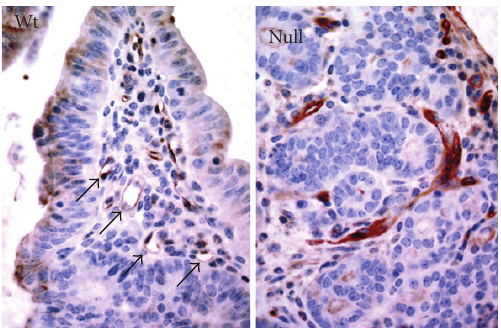
Figure 3: Analysis of microvessels in intestinal adenomas from APC + / min mice in a PPARb + / + or PPARb − / − background (31 ± 3 weeks old mice) by aquaporin-1 immunostaining of para ffi n sections (brown). Arrows point to normal microvessels in tumors from PPARb + / + mice, lacking in PPARb − / − mice. Highly aberrant vascular structures lacking a lumen are seen specifically in Pparb − / −